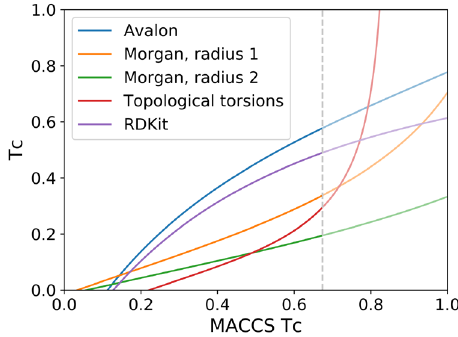
Figure 3. Corresponding Tc values for fingerprints of different design. The graphs show the relation of MACCS Tc values to Tc values of other fingerprint designs with corresponding significance scores. The dashed line corresponds to a significance of 0.99.